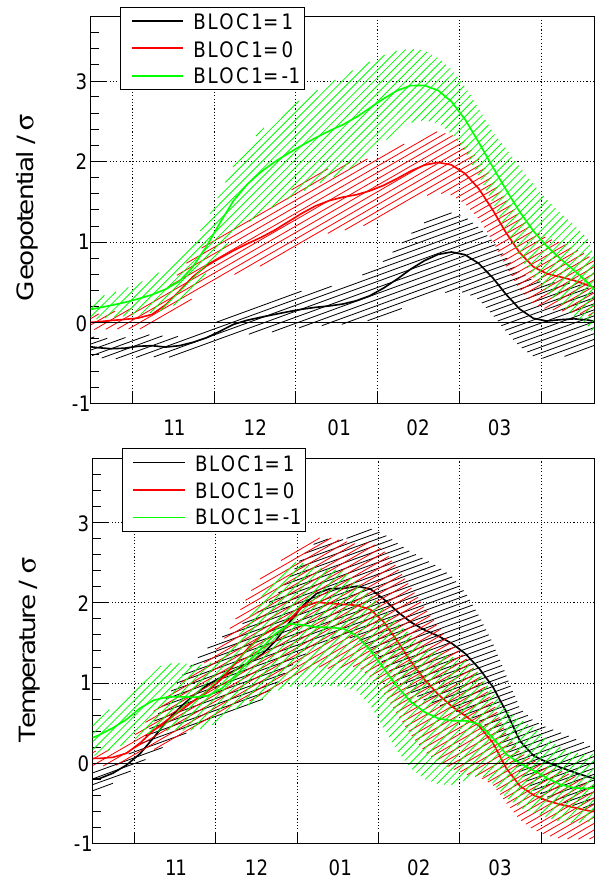
Fig. 4. MLP forecast for the winter 2011/12, holding the external factors constant and varying only the sine and cosine terms. The as- sumptions about the external factors are partly received from predic- tions made by the NOAA and partly from scientific reasoning (see text). The forecast is shown for geopotential (top) and temperature (bottom) for three different conditions of BLOC1. The hatched area denotes the 95% confidence interval calculated from the 30 model realizations. Please note the additional uncertainty imposed by the only moderate hindcasting performance (see right panel of Fig.